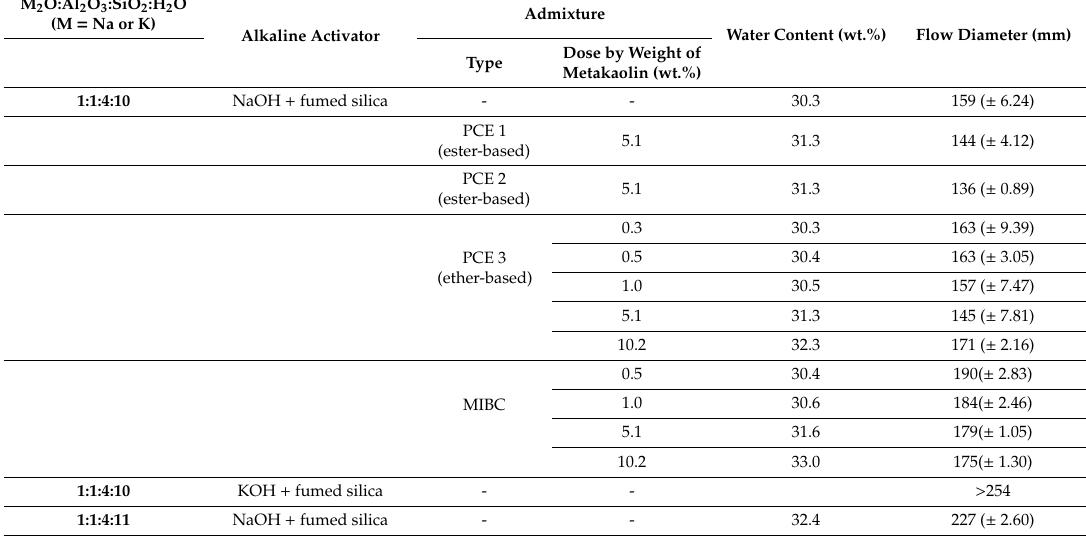
Table 1. Mixture design of metakaolin-based geopolymers with admixtures. Spread diameter of the fresh geopolymer mixtures was expressed in mm. Methyl isobutyl carbinol (MIBC) gave better performance in terms of flowability, but the higher amount of admixtures resulted in the inverse e ff ect. The slurry of 1:1:4:10 K-geopolymer overflowed from the disc and its flow diameter was assumed to be more than 254